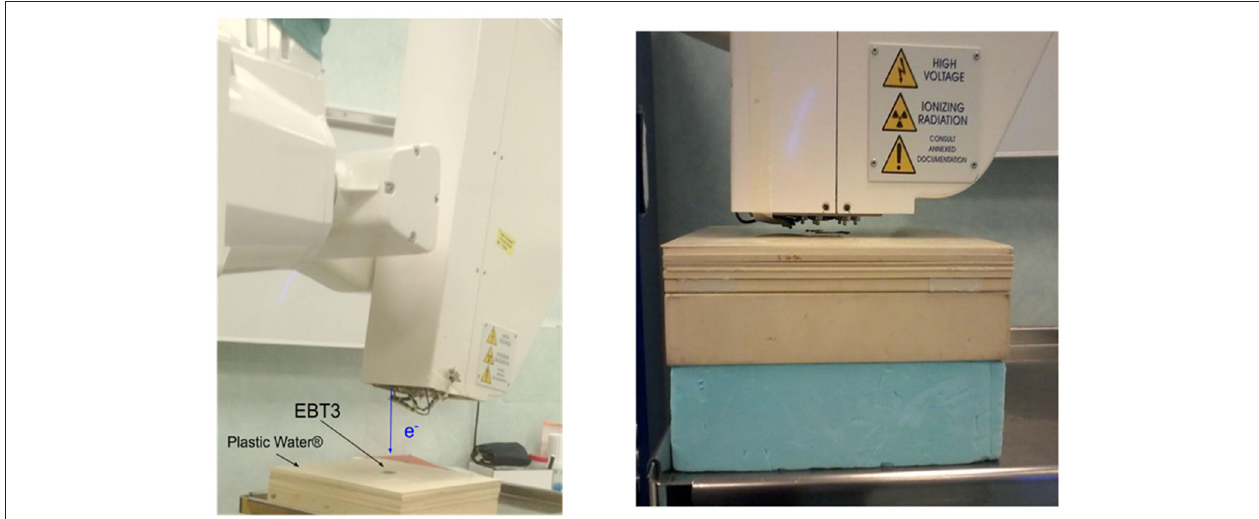
FIGURE 3 | Schematic view of the experimental set-up. On the left, the set-up with the accelerator head. On the right, the configuration during the irradiation (notice the proximity between beam window exit and the Plastic Water ® slabs).